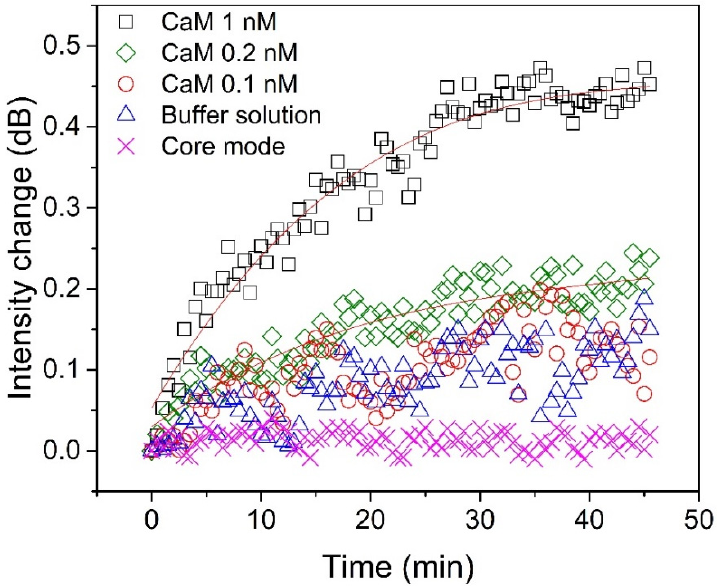
Figure 5. Detection of calmodulin at concentrations of 1 nM (black ” □ ”), 0.2 nM (green “ ◇ ”), and 0.1 nM (red ” ○ ”) compared with buffer solution without calmodulin (blue ” ∆ ”). The intensity changes of the core mode (pink “X”), at 1540 nm, as it varied with time is also shown.